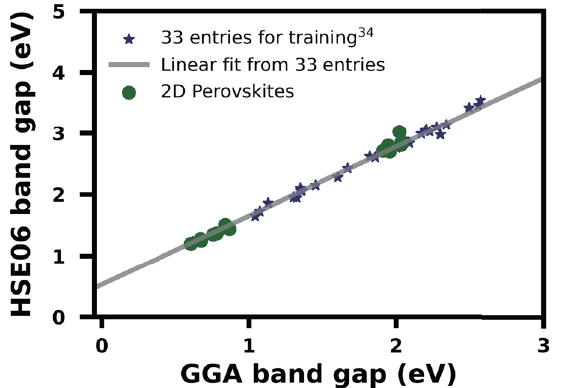
Fig. 6 Plot of the GGA vs. HSE06 band gap for the 14 HOIP candidates (green circles) along with a linear regression fi t from our previous investigation 33 . The GGA-based band gap can be translated to an HSE06-based calculated version and vice versa by using this linear fi t result.